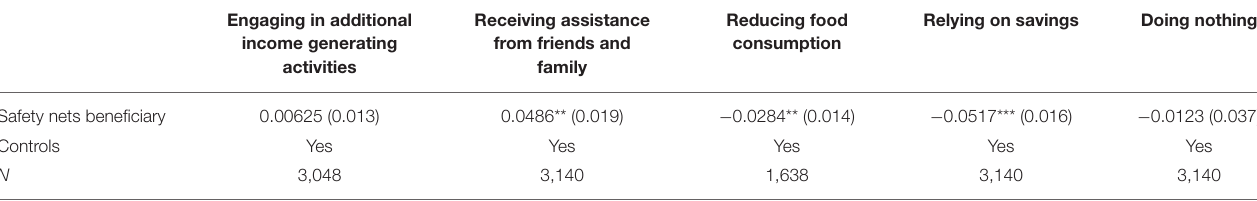
TABLE 8 | Male head regression results on safety